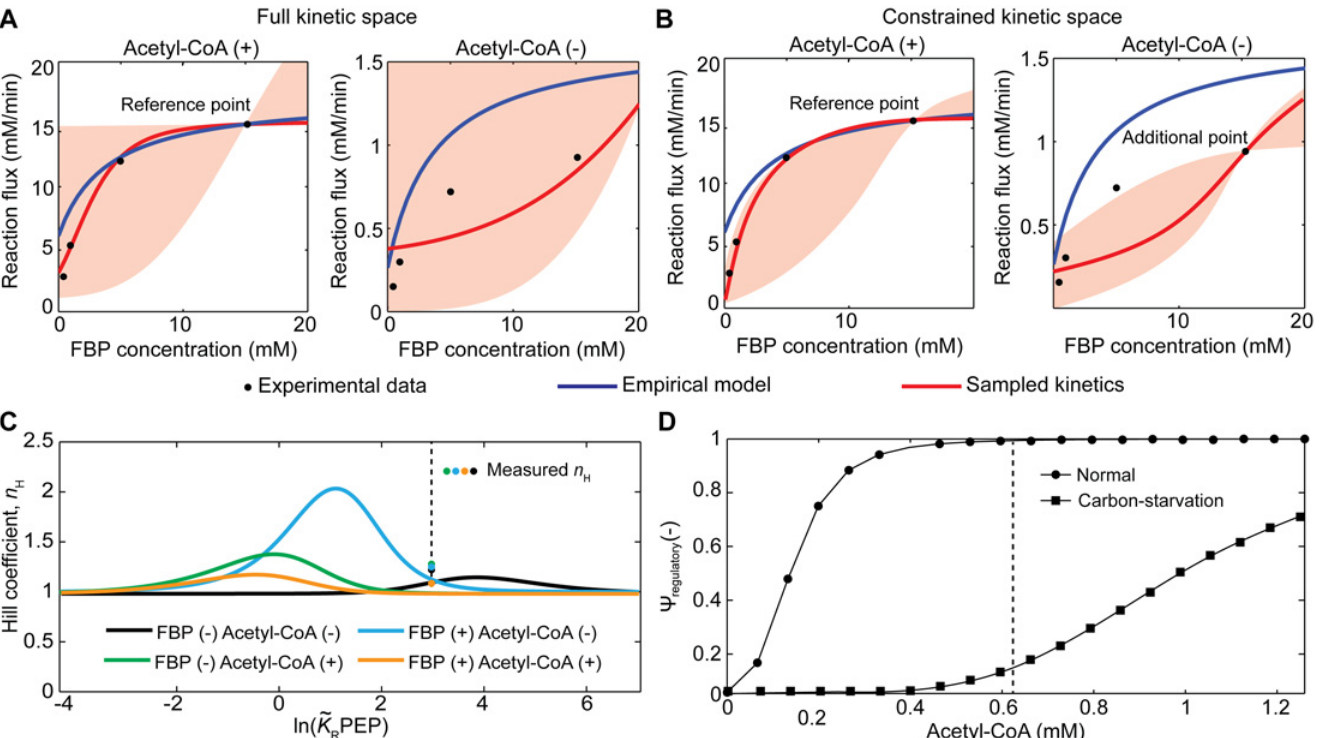
Fig 7. Modelling the regulatory co-activation behaviour of PEPC upon FBP and Acetyl-CoA binding. (A) Comparison of the kinetic behaviour described by the empirical model of Lee et al. [59] (blue line) and the best sampled kinetics using our framework (red line) with and without Acetyl-CoA. The substrates concentrations used in each case were: 2 mM PEP, 10 mM bicarbonate, 15 mM FBP and 0.63 mM acetyl-CoA, which correspond to the physiological concentrations found in E . coli in glucose-limited cultures [58]. The red shaded area denotes a 99% confidence region for 10 4 instances sampled. (B) Comparison of the kinetic behaviours including additional information during the sampling. The legends and concentrations used are the same as in (A). (C) Hill coefficient curves for the most accurate PEPC model sampled in the presence and absence of FBP and acetyl-CoA at physiological concentrations. The coloured circles denote experimentally determined Hill coefficients under conditions resembling physiological concentrations of PEP, FBP and acetyl-CoA [55]. (D) Regulatory kinetic behaviour described by the PEPC model with 15 mM of FBP (black circles), i . e . physiological condition, and 0.45 mM of FBP (black squares), i . e . carbon-starvation condition, for different acetyl-CoA concentrations. The dashed line represents the physiological concentration of 0.63 mM Acetyl-CoA found in E . coli under normal physiological conditions.